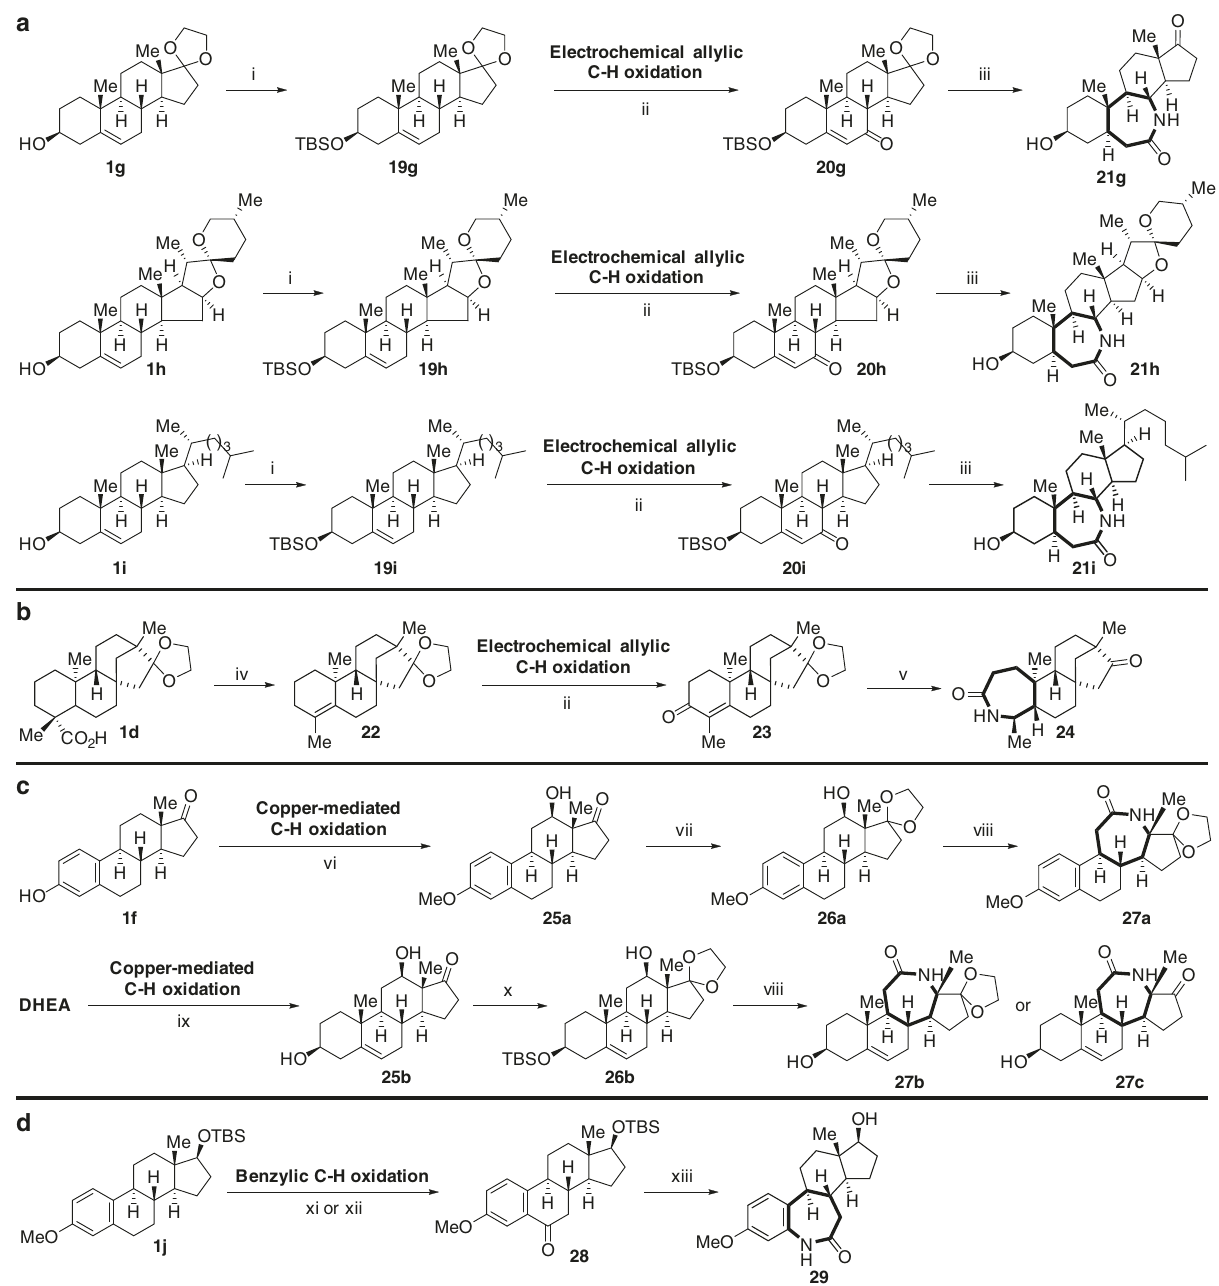
Fig. 3 Diversi fi cation of polycyclic natural products by sequential C – H oxidation and ring expansion. a Electrochemical C – H oxidation/B-ring expansion of DHEA, cholesterol and Diosgenin. b Electrochemical C – H oxidation/A-ring expansion of isosteviol. c Copper-mediated C – H oxidation/C-ring expansion of DHEA and estrone. d Benzylic C – H oxidation/C-ring expansion of estrone. (i) TBSCl, imidazole, CH 2 Cl 2 , rt; (ii) LiClO 4 , Py, t -BuOOH, Cl 4 NHPI, acetone,